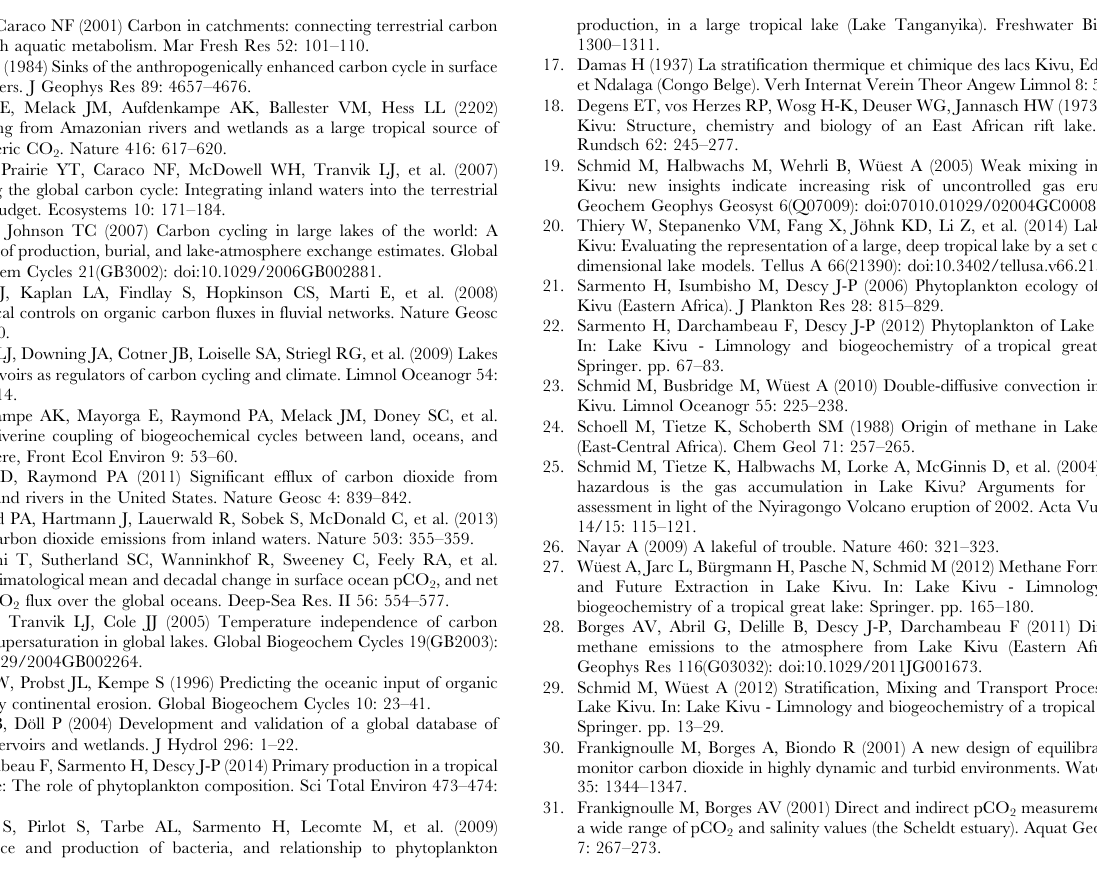
Table S1 Data-set of depth (m), water temperature ( u C),